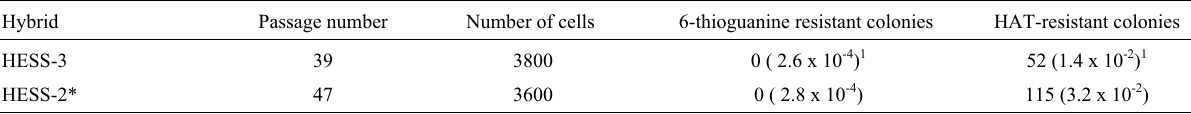
TableII -Comparisonofplatingefficiencyofthehybridcellsinthepresenceof6-thioguanineandHAT(100 µ Mhypoxanthine,0.4 µ Maminopterinand 16 µ M thymidine).